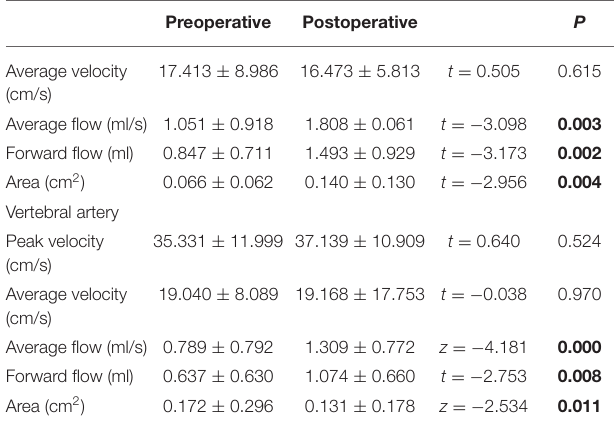
TABLE 3 | Postoperative hemodynamic changes of patients with MMD (33